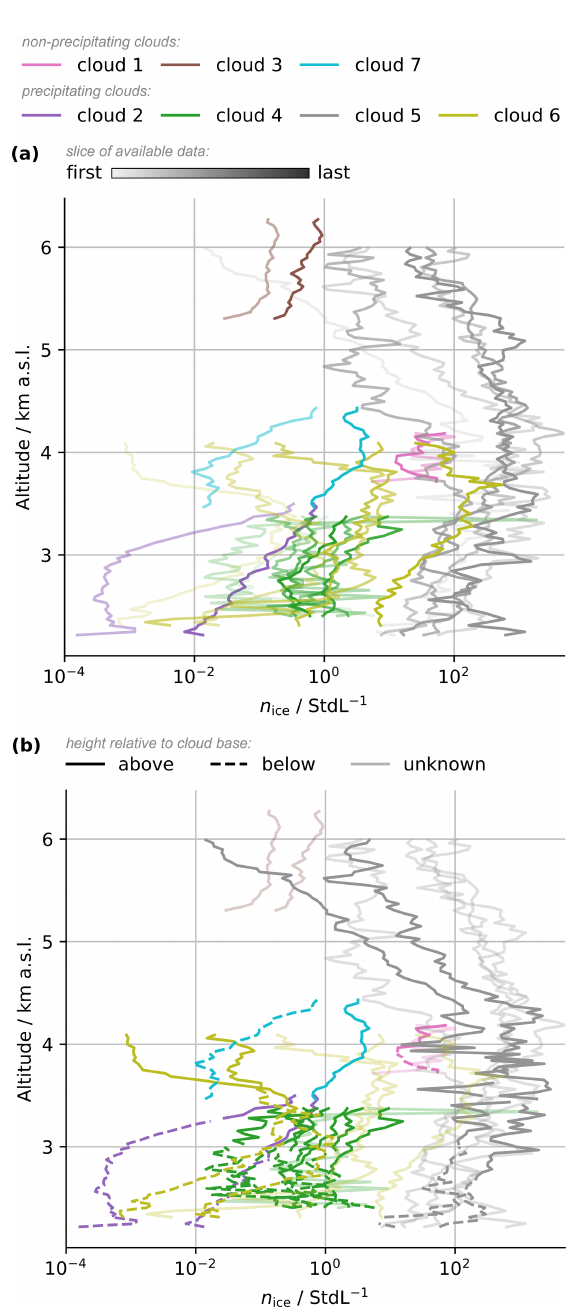
Figure 10. Median ice crystal number concentrations (ICNCs) as a function of altitude for each cloud and for time slices of approxi- mately 1h. (a) Temporal evolution of the ICNC ( n ice ) profiles: the faintest colors correspond to the first slice of data, and the strongest colors correspond to the last slice of data. ( (b) Cloud regime clas- sification for each time slice: ICNCs ( n ice ) taken above cloud base (solid), below cloud base (dashed), and for an unknown cloud base (faint color). For cloud 3, the cloud base could not be determined.